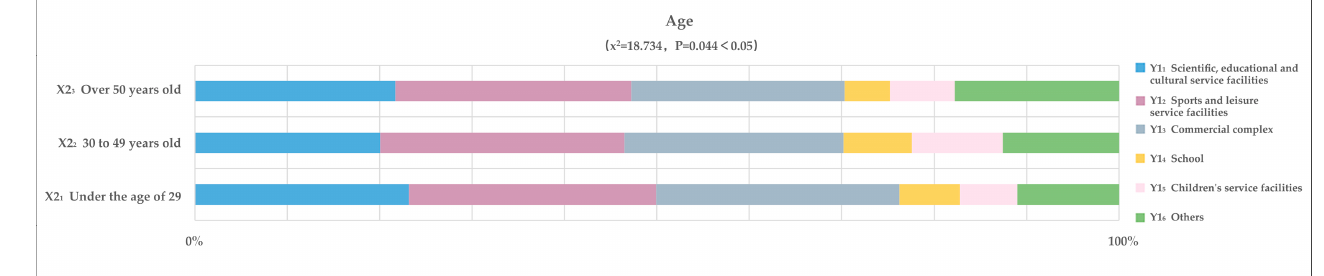
Figure 11. Demand from different age groups.